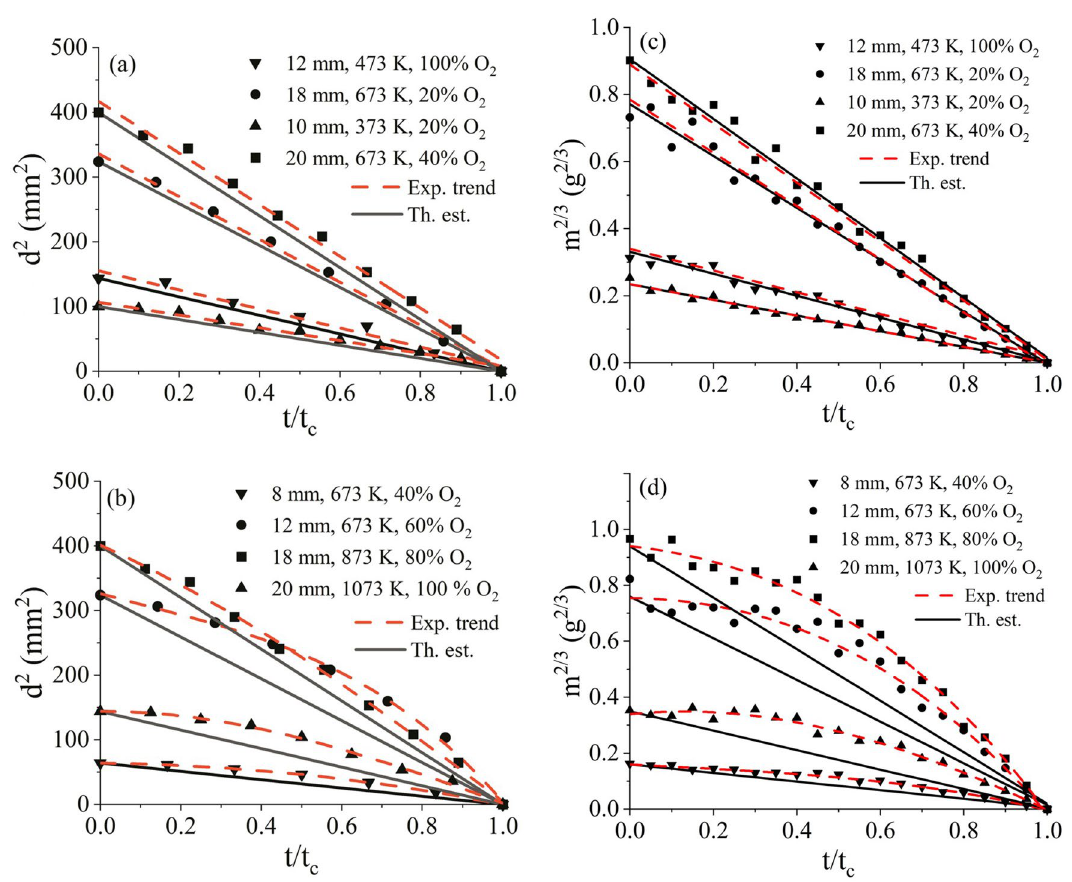
Figure 4. Temporal evolution of squared particle diameter ( d time ( t / t c ) for different sized particles, temperature and O 2 concentrations ( a ) adherence to d corresponding mass loss profile), ( b ) deviating from d analyzing d p is 0.05